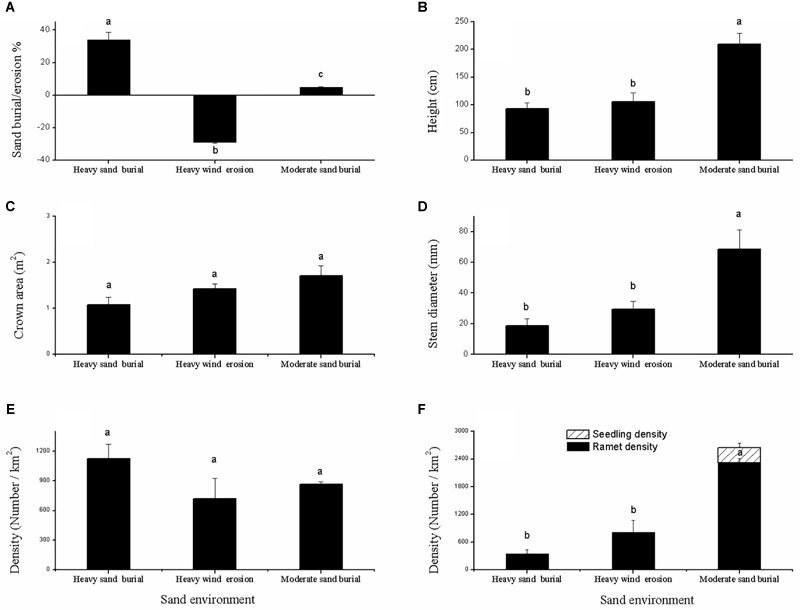
Description of the population dynamics of Calligonum mongolicum in various sand dune environments, including heavily buried, moderately buried, and wind-eroded sites. (A) Sand buried or wind eroded depth of mature shrub; (B) height of mature shrub; (C) crown area of mature shrub; (D) stem diameter of mature shrub; (E) density of mature shrub; (F) density of seed seedlings and clonal ramets. [Different lowercase letters denote significant differences (p < 0.05) among sand dune environments].